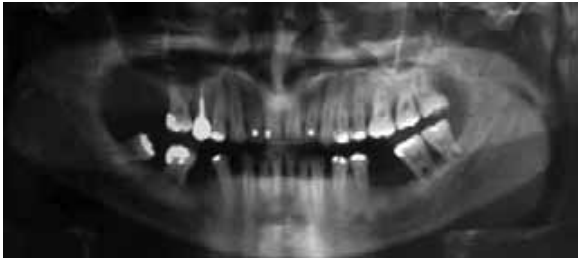
Figure 2 – Panoramic radiograph shows areas of bone resorption of the premolar and molar teeth